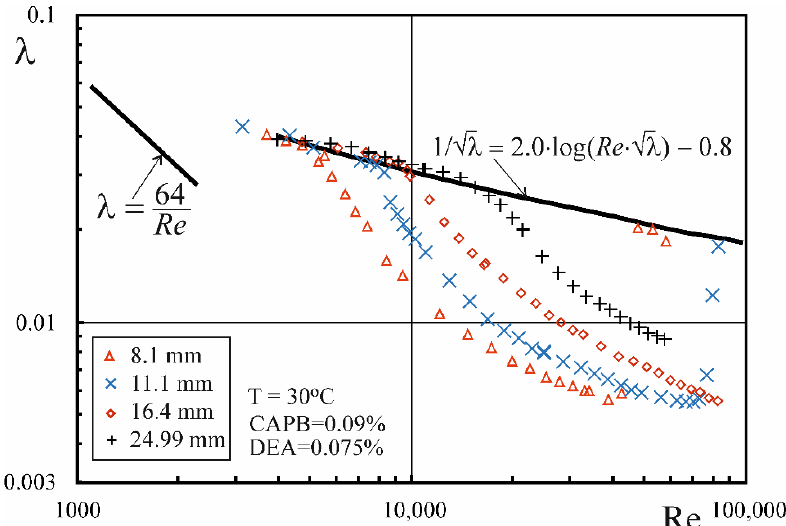
Table 4. Values of Re c ,0 and τ w , c 0 for pipes of different diameters (CAPB/DEA = 0.09%/0.075%; T = 30 °C).